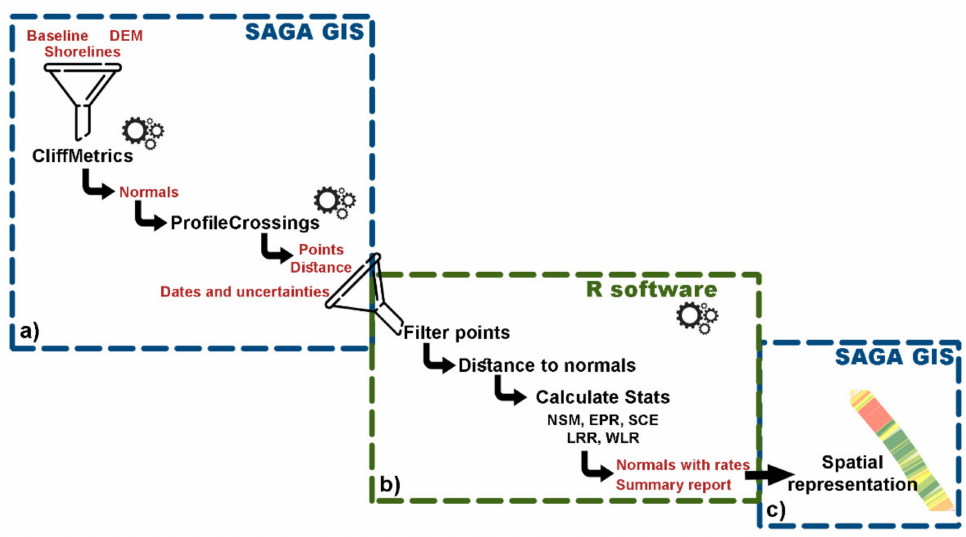
Figure 4. ODSAS workflow. The mandatory inputs and outputs used in each process are indicated in red text. ( a ) The SAGA process is used to generate the intersection point and the distances from baseline; ( b ) the R process is used to filter and calculate the main statistics; and ( c ) optional spatial representation from the previous